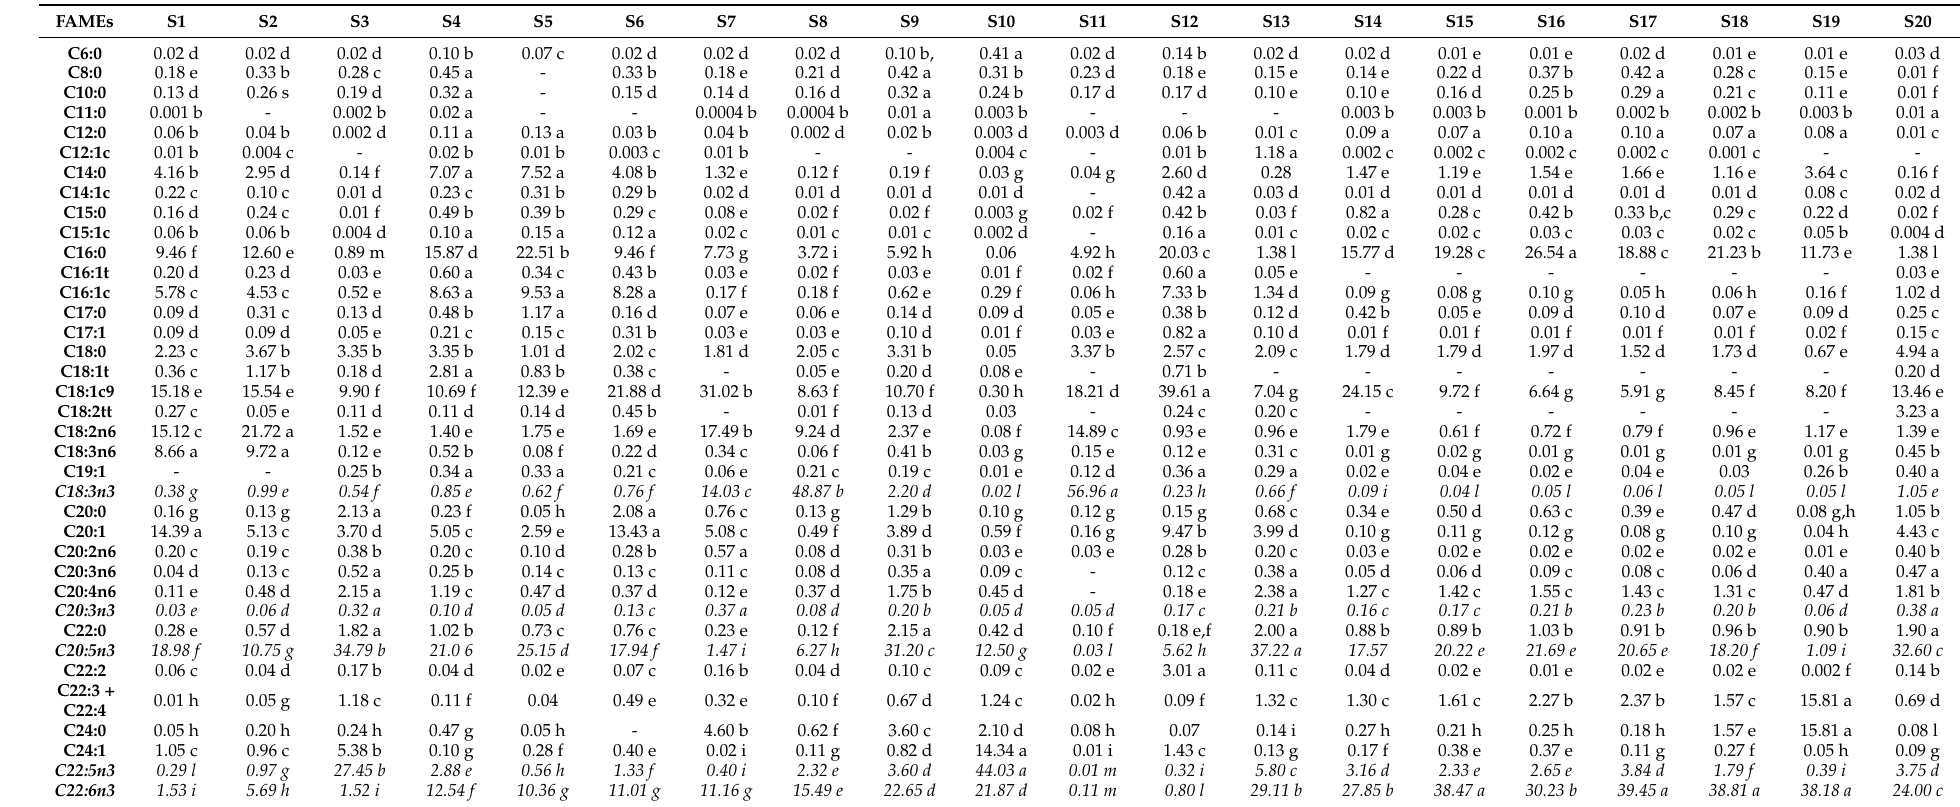
Table 2. Fatty acid content (g/100 g FAMEs) of omega-3 supplements ( n =